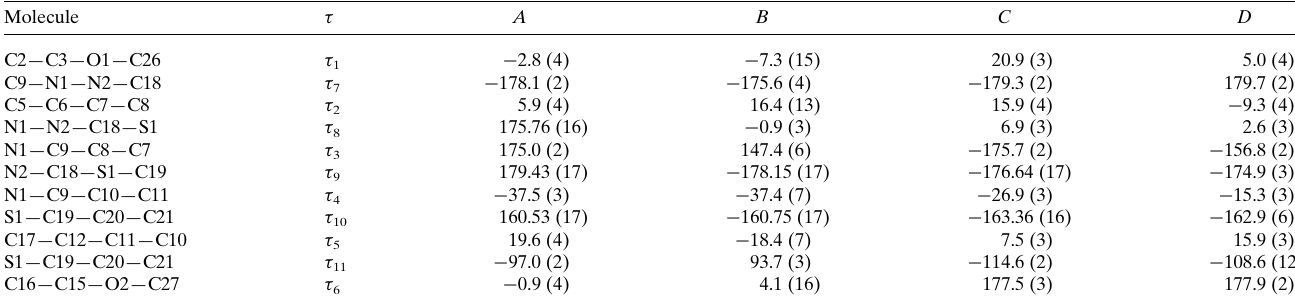
Table 1 Selected torsion angles ( (cid:2) ) in the four molecules of ( I ). Torsion angles for the minor disorder component were omitted.